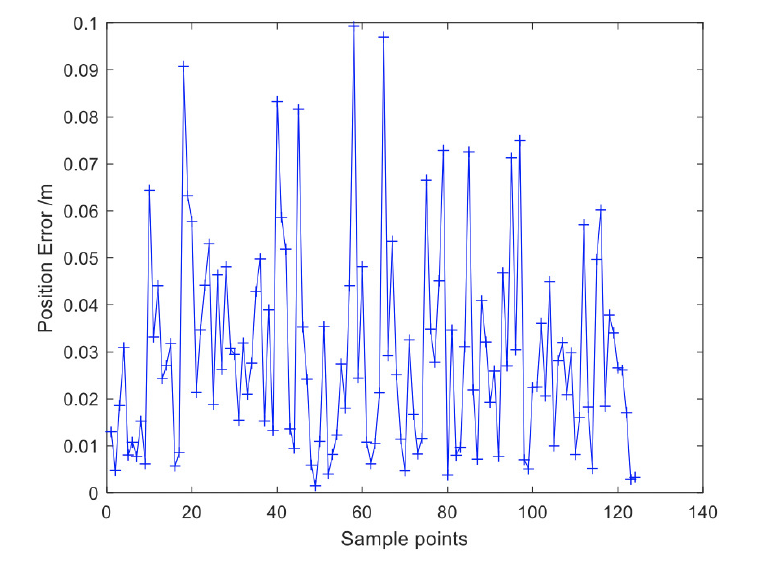
Figure 11. The RPE between fusion positioning system and